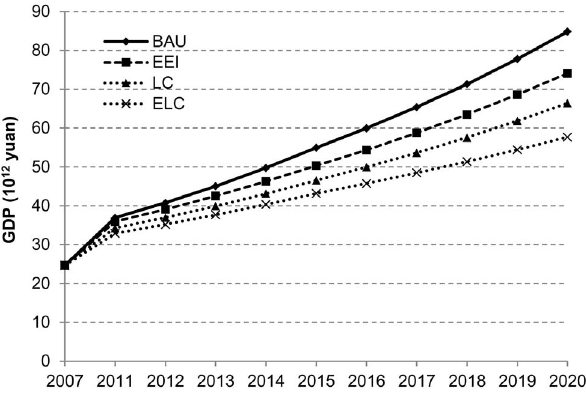
Figure 1. China’s GDP growth under BAU, EEI, LC and ELC scenarios (Scenarios are defined in Table 2).